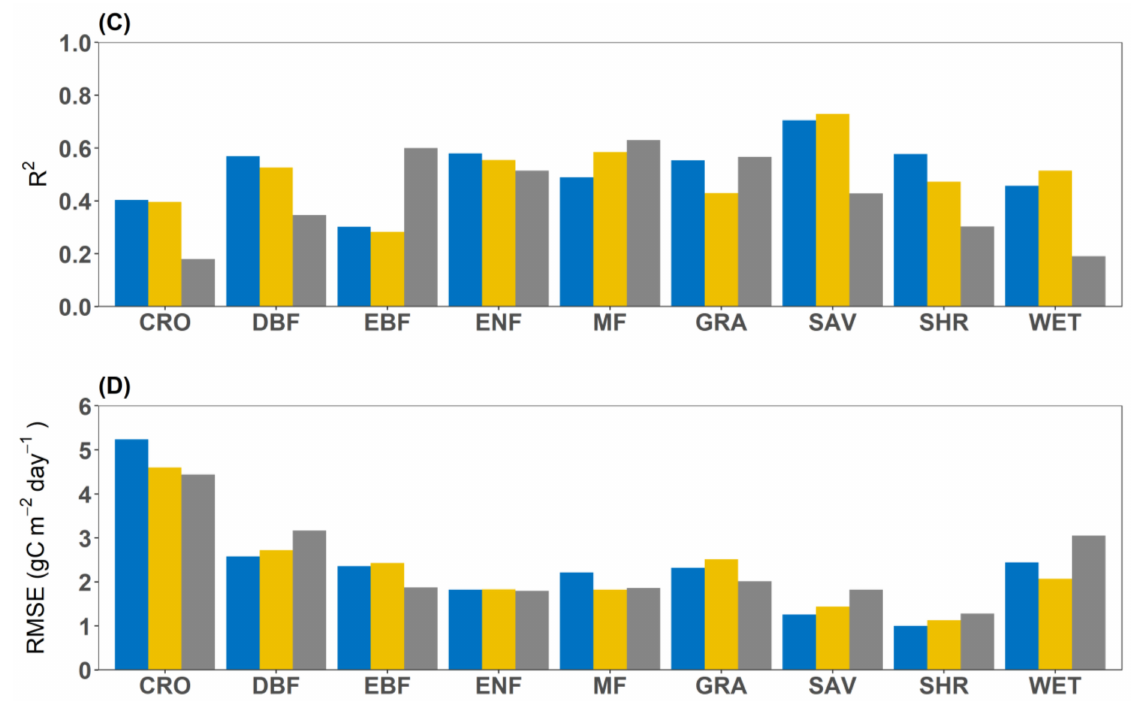
Figure 8. ( A ) Proportion of three types of reconstructed NDVI data and ( B ) relative prediction error (RPE), ( C ) R 2 , and ( D ) RMSE of GPP driven by different reconstructed NDVI among nine vegetation types. All the NDVI and GPP data were collected from the 193 investigated